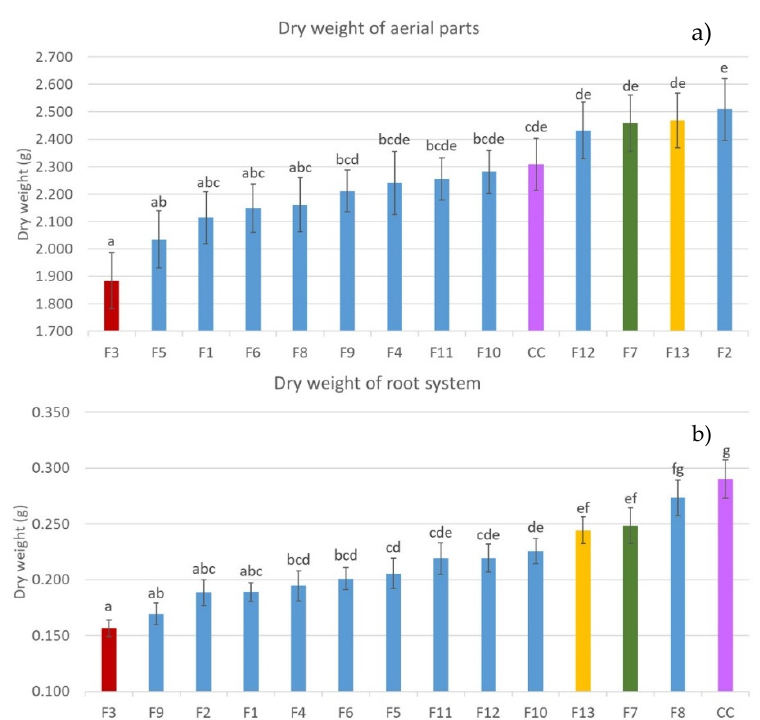
Figure 2. Dry weight of the aerial parts ± SD (standard deviation bar) ( a ) and root system ( b ) of 60-day-old plants. F. oxysporum (F1–F12), F. solani (F13), and control without fungus (CC). Values are means ± SE of 30 plants. Columns with di ff erent colors indicate selected treatments for further assays; CC (purple), F. oxysporum F3 (red), F. oxysporum F7 (green), and F. solani F13 (yellow). The data were compared by analysis of variance (ANOVA) and Fisher least significant di ff erence (LSD). Di ff erent letters mean statistically significant di ff erences ( p < 0.05) between